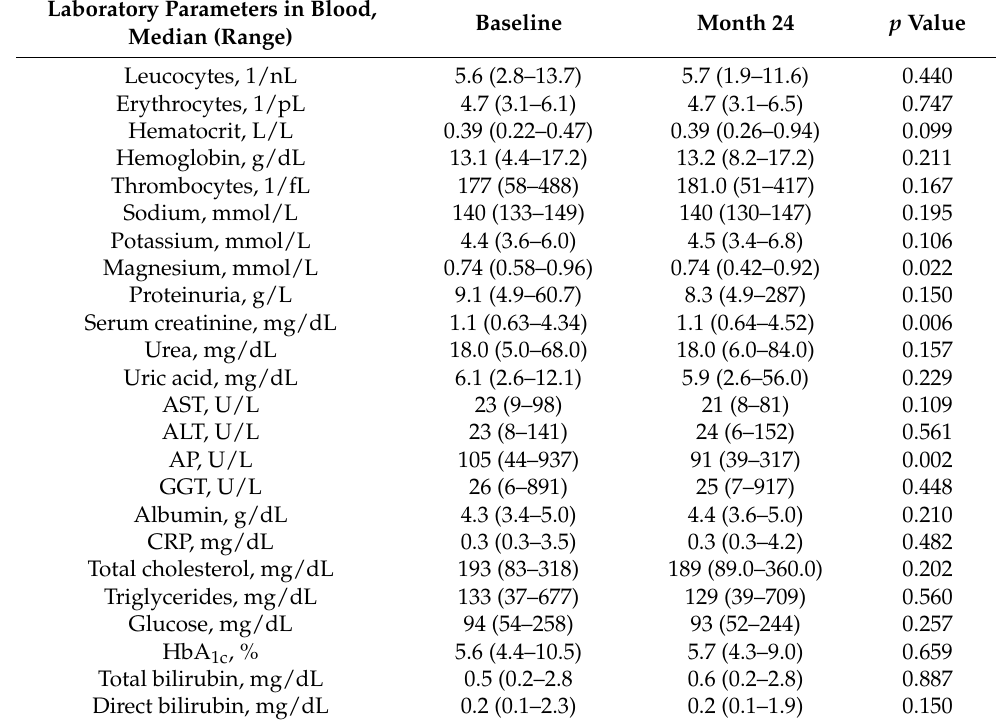
Table 2. Laboratory parameters at baseline and at 24 months after switching to LCPT.